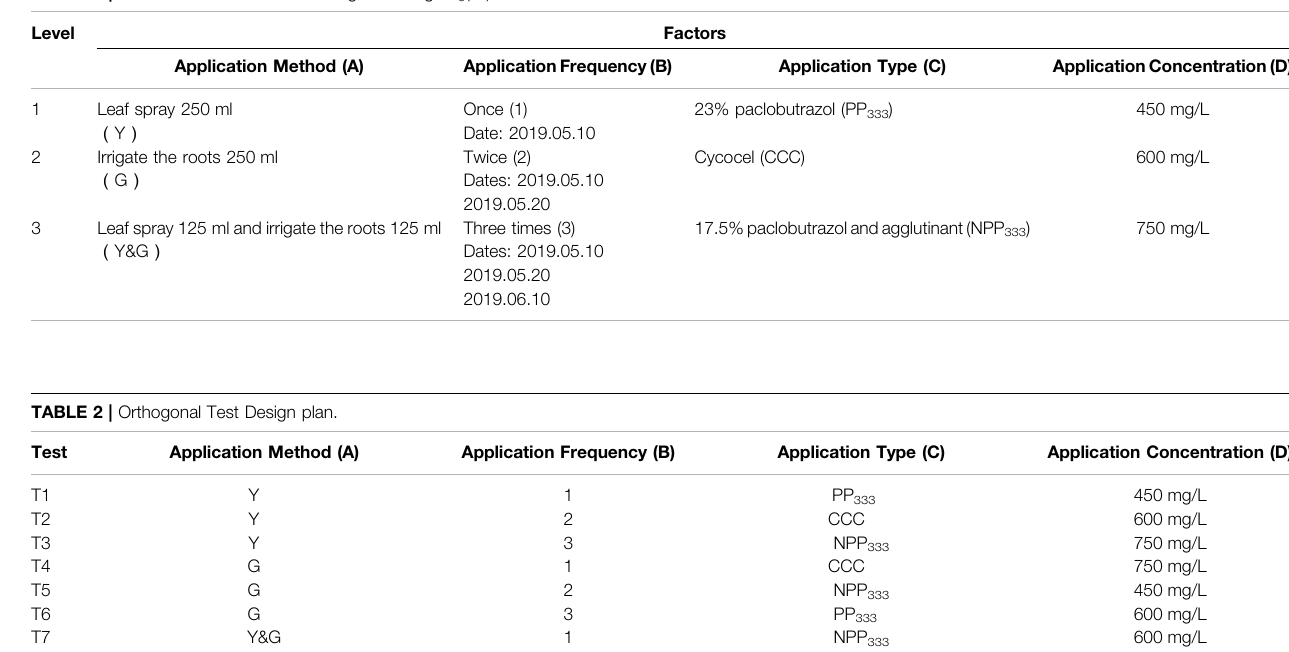
TABLE 1 | The factors and levels of orthogonal design L 9 (3 4 ).